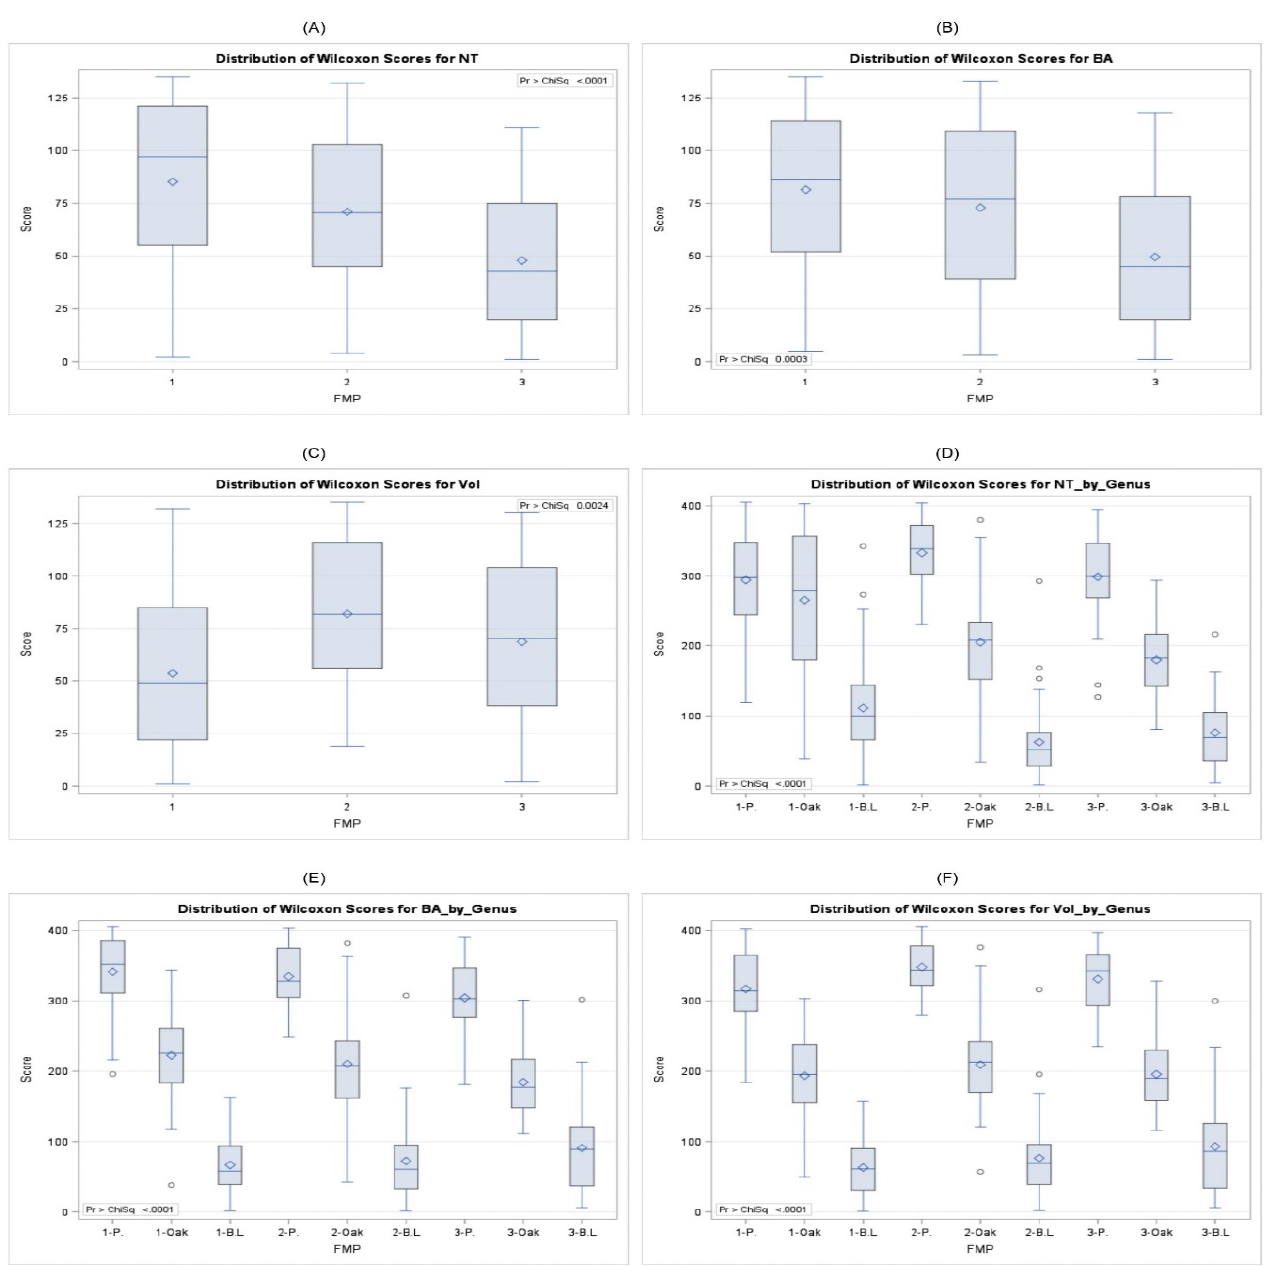
Figure 10. Boxplot diagrams for the number of trees ( A ), basal area ( B ), and volume ( C ) of the total by forest management plan (FMP). Boxplot diagrams for the number of trees ( D ), basal area ( E ), and volume ( F ) of the total by FMP in each genus. P: pine; B.L: broadleaf trees.